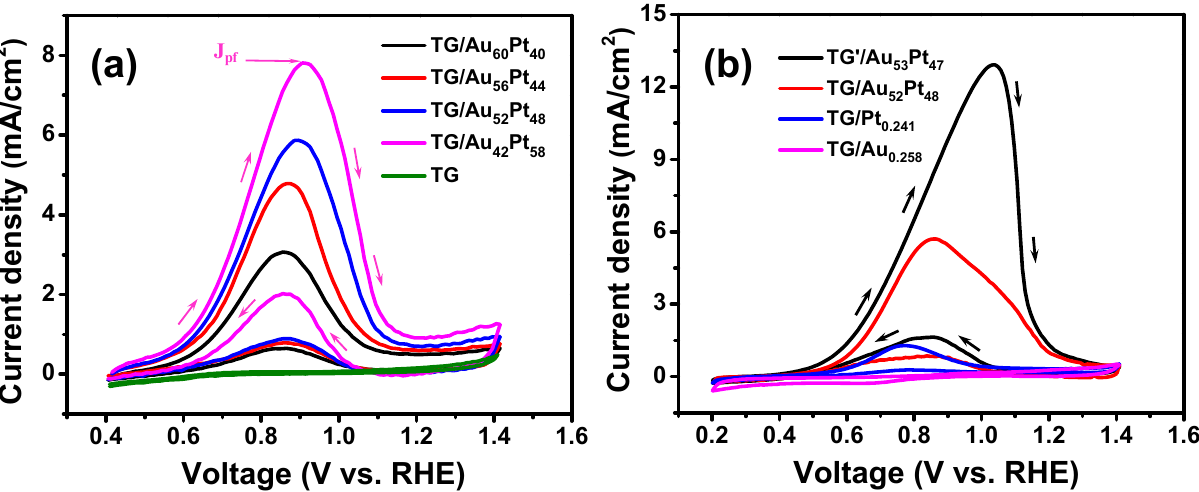
Figure 7. CVs of methanol oxidation on different TG-based catalysts (TG, and TG/Au x Pt y ( a ), TG’/Au 53 Pt 47 , TG/Au 52 Pt 48 , TG/Pt 0.241 and Pt/Au 0.258 ( b )) measured in 0.5 M KOH + 1 M CH 3 OH solution. Table 2. The J pf , onset potential ( E onset ) and ECSA of TG-based catalysts. Catalyst